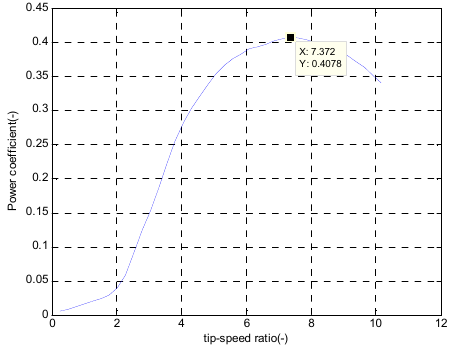
Figure 15. Power coefficient of wind turbine in function of tip speed ratio.